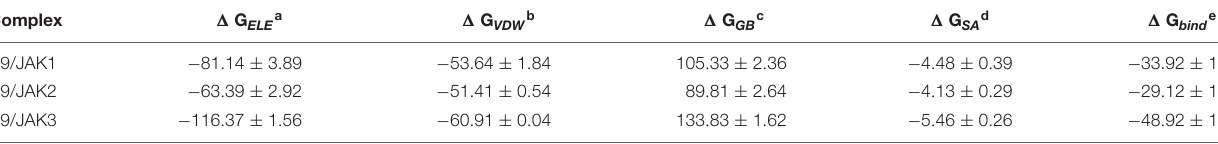
TABLE 5 | Binding free energies (kcal/mol) for D9 with JAKs using the MM/GBSA method along with specific energy contributions. Complex